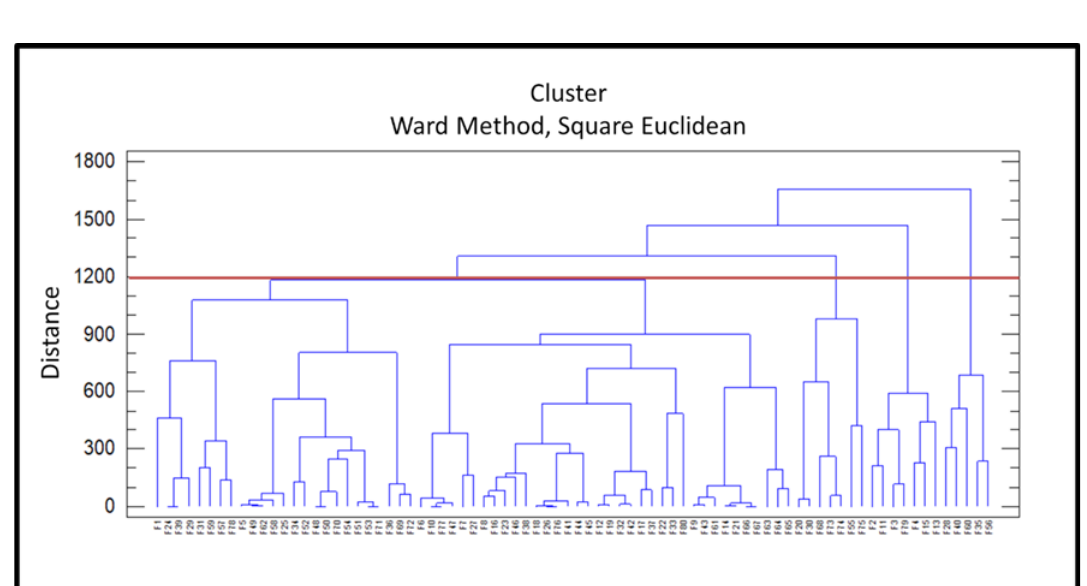
Figure 4. Dendrogram of the banana farms in the Cuyani Microbasin, district of Pichanaki,